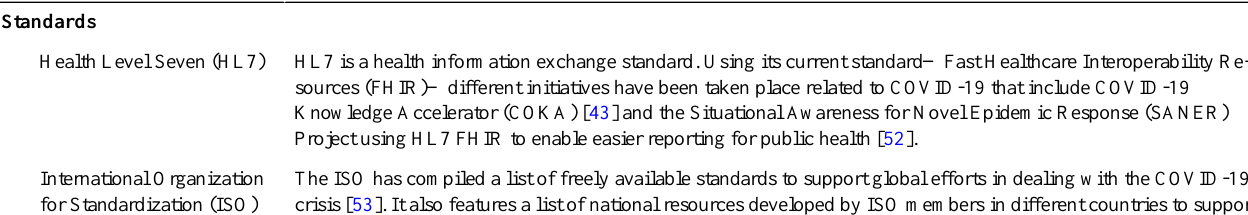
Table 6. Summary of tertiary resources related to COVID-19–based standards, guidelines, and terminologies. InitiativesCategory and